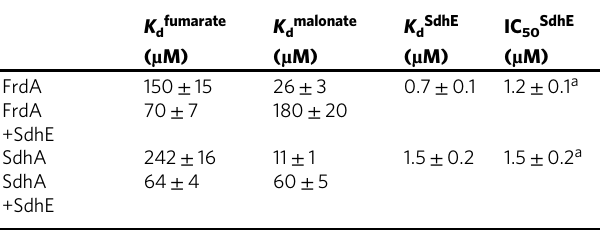
Table 2 Effect of SdhE on the kinetic parameters of isolated FrdA and SdhA subunits